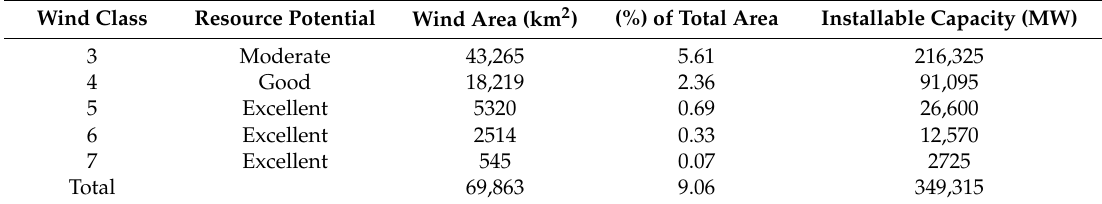
Table 1. Wind resource assessment of Pakistan at 50 m height